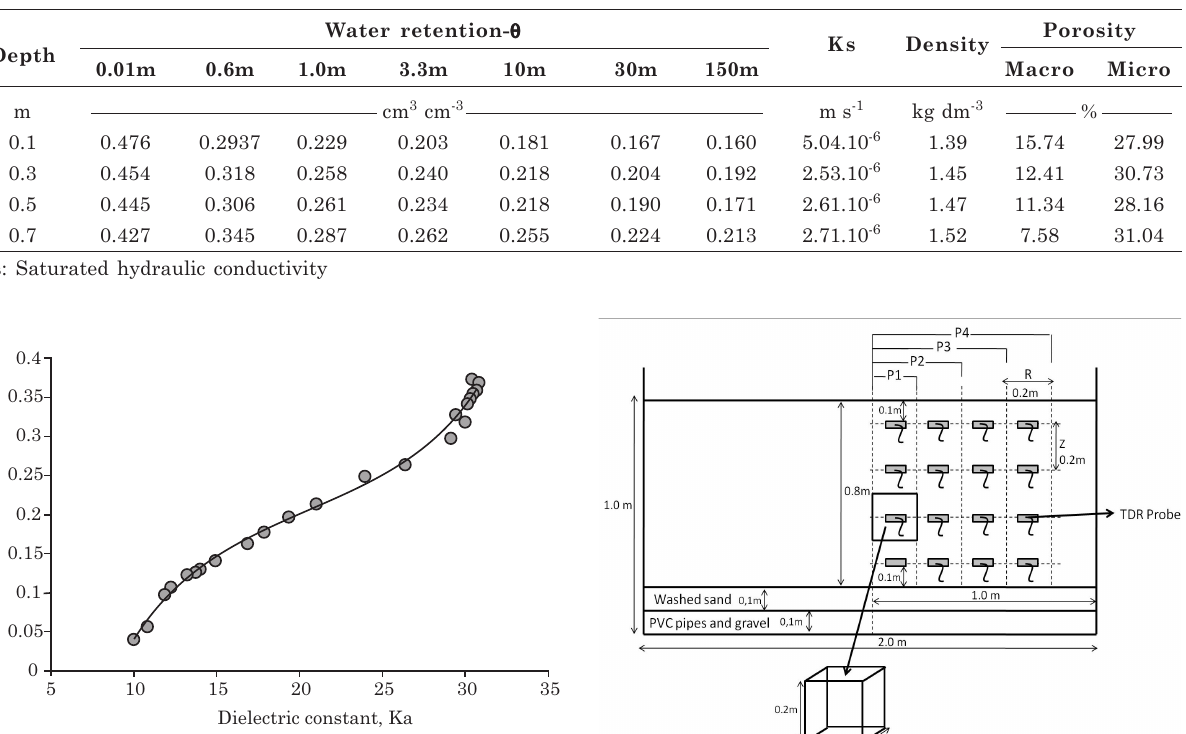
Table 1. Hydro-physical characteristics of the soil used to fill the lysimeters